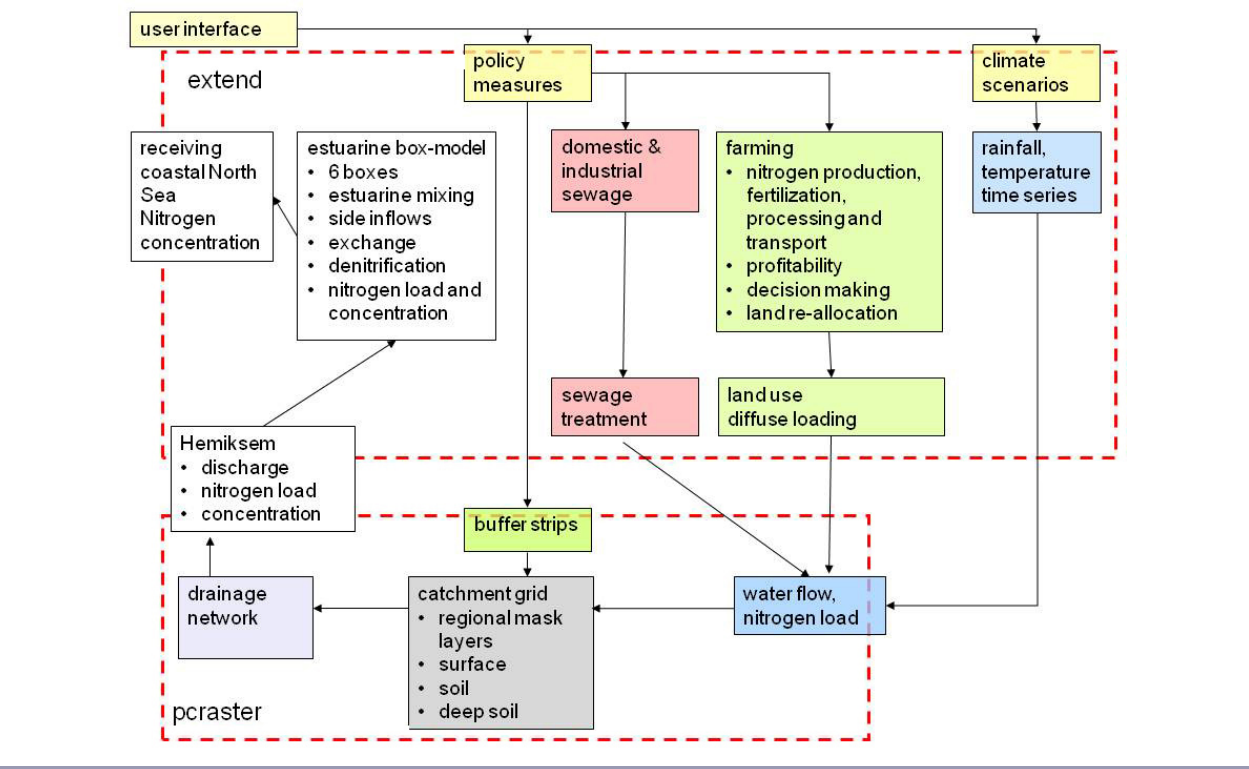
Fig. 1. General structure of the model suite of water and nitrogen flowing through the Scheldt catchment, developed using PCRaster and ExtendSim. Policy measures and climate scenarios can be manipulated by the user.